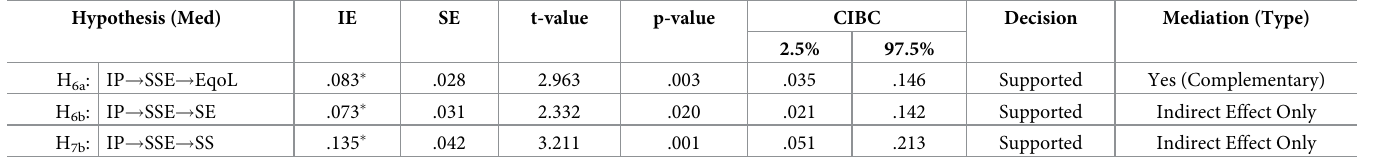
Table 6. Indirect effects hypotheses, results, conclusions, and mediation type. Hypothesis